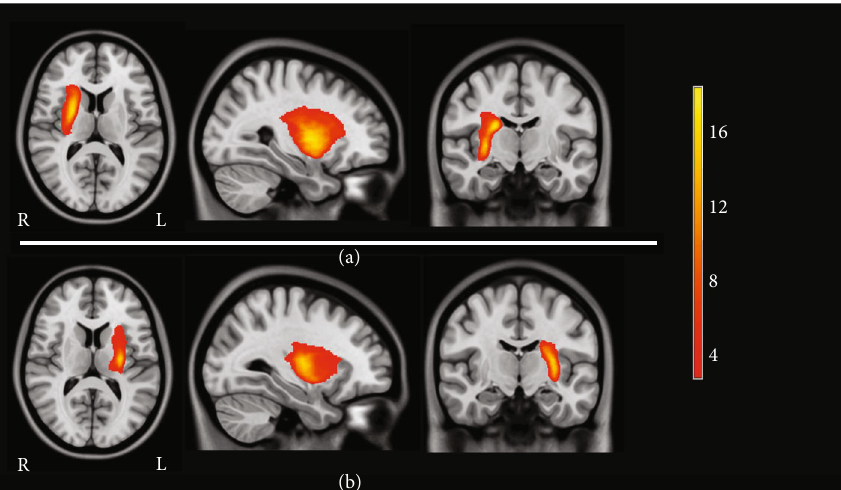
Figure 1: Lesion probability map for patients with subcortical stroke. (a) Lesion distribution in right-sided stroke patients; (b) lesion distribution in left-sided stroke patients. Color bar denotes lesion incidence frequency. Abbreviations: L =left hemisphere; R =right